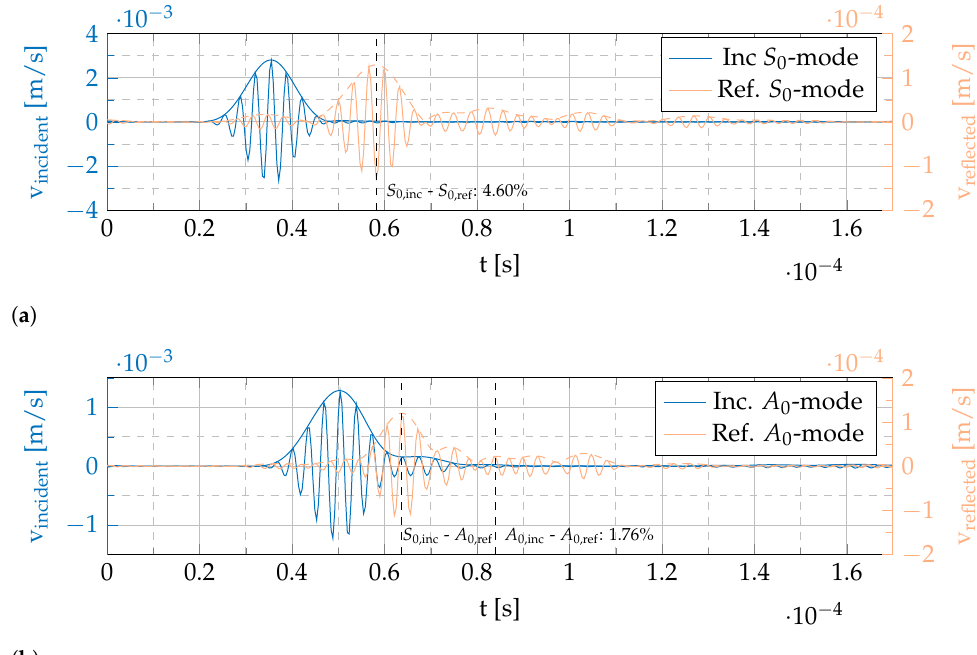
Figure 9. Exemplary experimentally determined reflection quantification at x investigate = 98mm using filtered signals from three-dimensional SLDV measurement in 2mm aluminum plate with surface- applied PZT sensor. ( a ) Filtered incident and reflected S 0 proportions of in-plane data. ( b ) Filtered incident and reflected A 0 proportions of out-of-plane